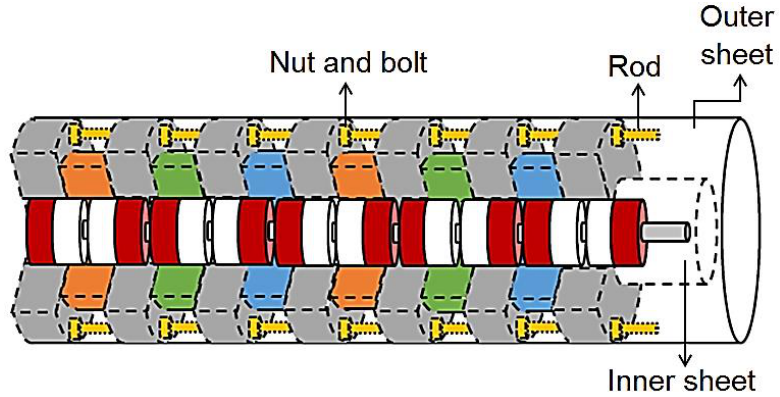
Figure 5. Manufacture illustration of the semi iron-cored LPMG.